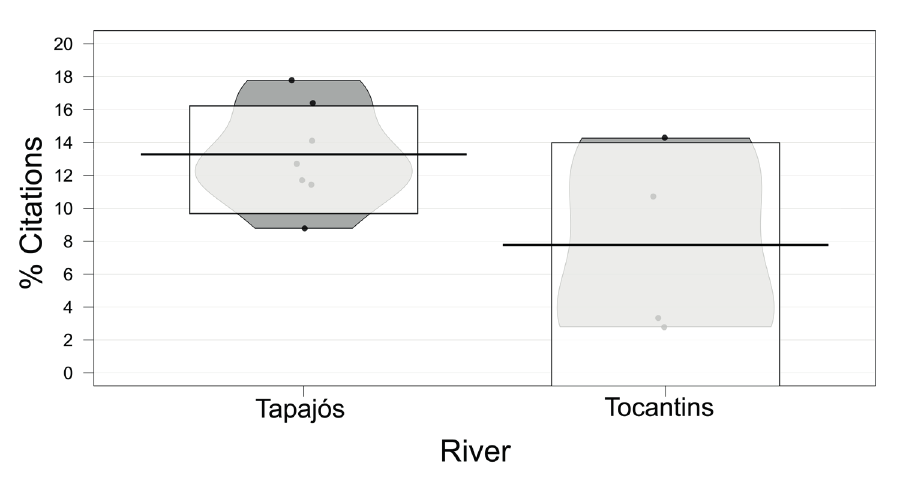
FIGURE 2 | Comparison of mean relative relevance to fisheries (% of citations in interviews) of Plagioscion squamosissimus according to the interviewed fishers in the Tapajós (n = 7) and Tocantins (n = 4) rivers. Mean (dark horizontal line), data distribution (bean gray area), data (points), confidence interval (rectangle). Points indicate the fishing communities, considered as replicates in this